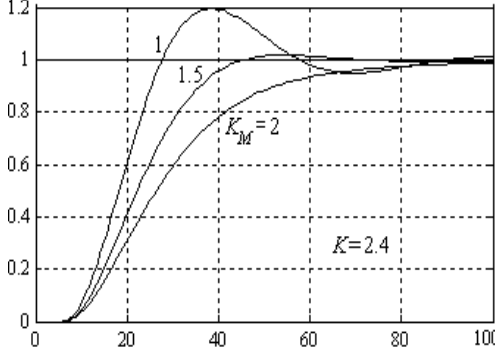
Figure 12. Responses y ( t ) to a unit step reference for τ M = 8, T sM = 73 and K M = 1; 1.5;